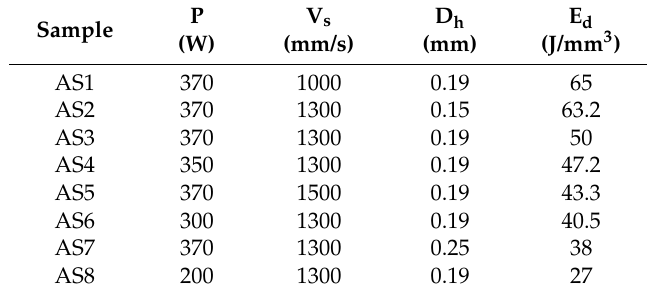
Table 1. The SLM process parameters applied for producing the AlSi10Mg_200C samples.